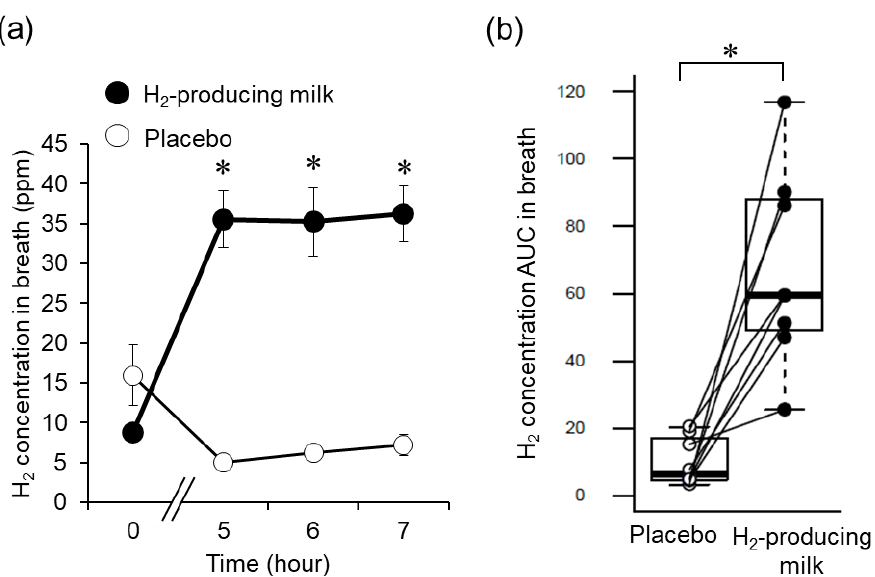
Figure 1. Changes in H 2 production with the ingestion of H 2 -producing milk. ( a ) Time course of the breath H 2 concentrations during the first 6 h after ingestion of the test beverage. Error bars represent standard error of the mean. * q < 0.05 (vs. placebo; Friedman and Wilcoxon signed-rank tests with the Benjamini–Hochberg correction). ( b ) Between-trial comparison of the area under the curve (AUC) of the breath H 2 concentrations (0–6 h). * p < 0.05 (Wilcoxon signed-rank test performed after the F-test). Each part of the boxplot diagram shows the following: upper line, maximum value; lower line, minimum value; box, interquartile range; bold line inside the box, median; and white and black plots, values during the placebo and H 2 -producing milk trials, respectively.